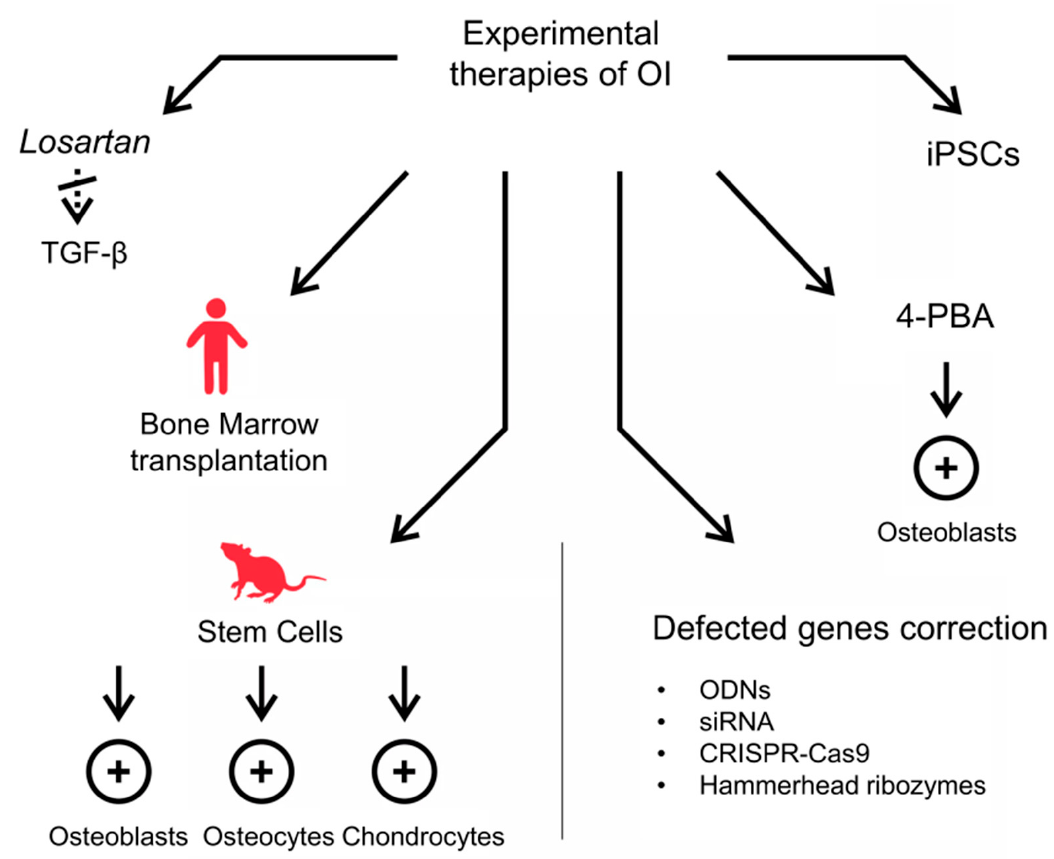
Figure 3. Summary of experimental strategies for OI therapy tested in in vitro, ex vivo, animal models and clinical trials. The promising strategies include (i) the use of Losartan, an angiotensin II-receptor agent with anti-TGF- β properties; (ii) mesenchymal stem cells transplantation as the source of osteoblasts, osteocytes, and chondrocytes; (iii) correction of defective genes, including ODNs, antisense oligodeoxyribonucleotides; siRNA, short interfering RNA; CRISPR–Cas9 and hammerhead ribozymes; (iv) restoring cell homeostasis to improve the severity of the OI phenotype using chemical chaperones, e.g., 4-PBA, 4-phenylbutyrate; (v) iPSCs, induced pluripotent stem cells use.